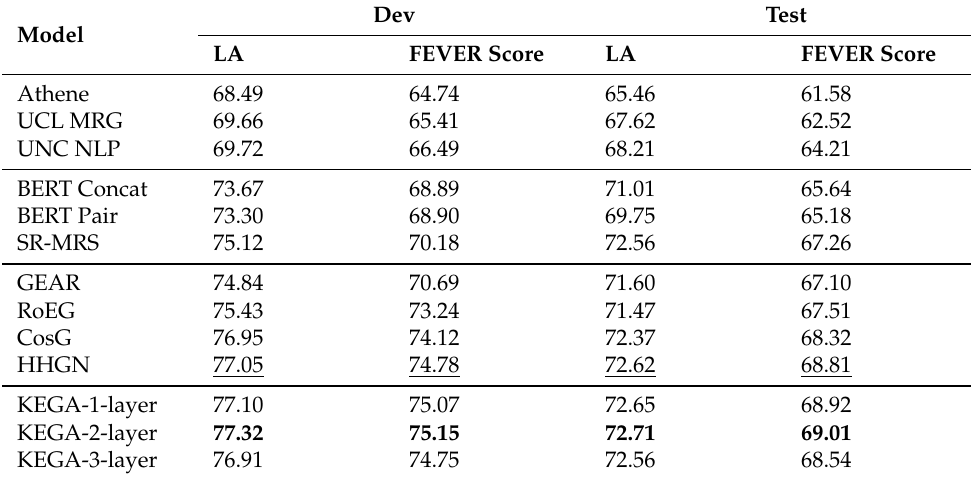
Table 3. Performance (%) of discussed models on the development (dev) set and the bind test set. The results produced by the best baseline and the best performer in each column are underlined and boldfaced,